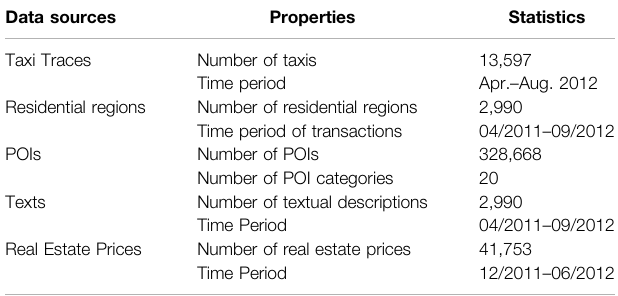
TABLE 1 | Statistics of the experimental